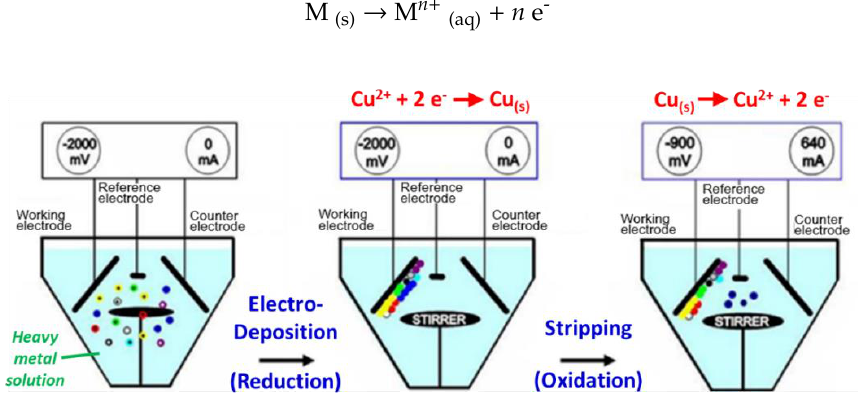
Figure 2. Three-stage reactions of dissolution voltammetry for monitoring heavy metals in water, exemplified by copper ions in water. Adapted from the report [6].